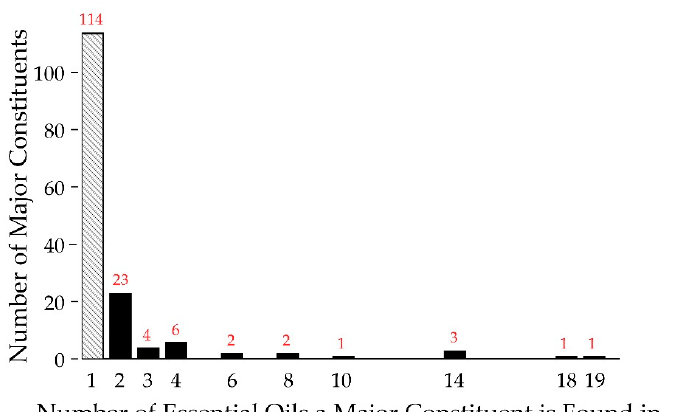
Figure 2. Major Constituent Frequency Histogram. Shown are the frequencies of occurrence for the major constituents of essential oils. A total of 114 major constituents are unique to one essential oil (far left, in gray), while one major constituent is found in 19 essential oils (far right). Red numbers indicate the population of a given